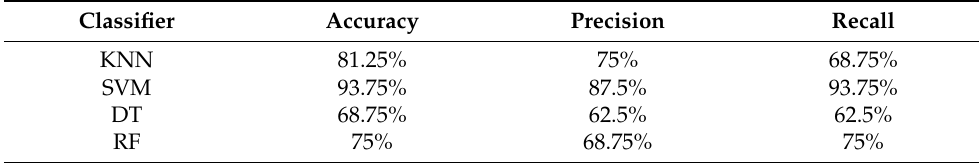
Table 2. Classification accuracy of association